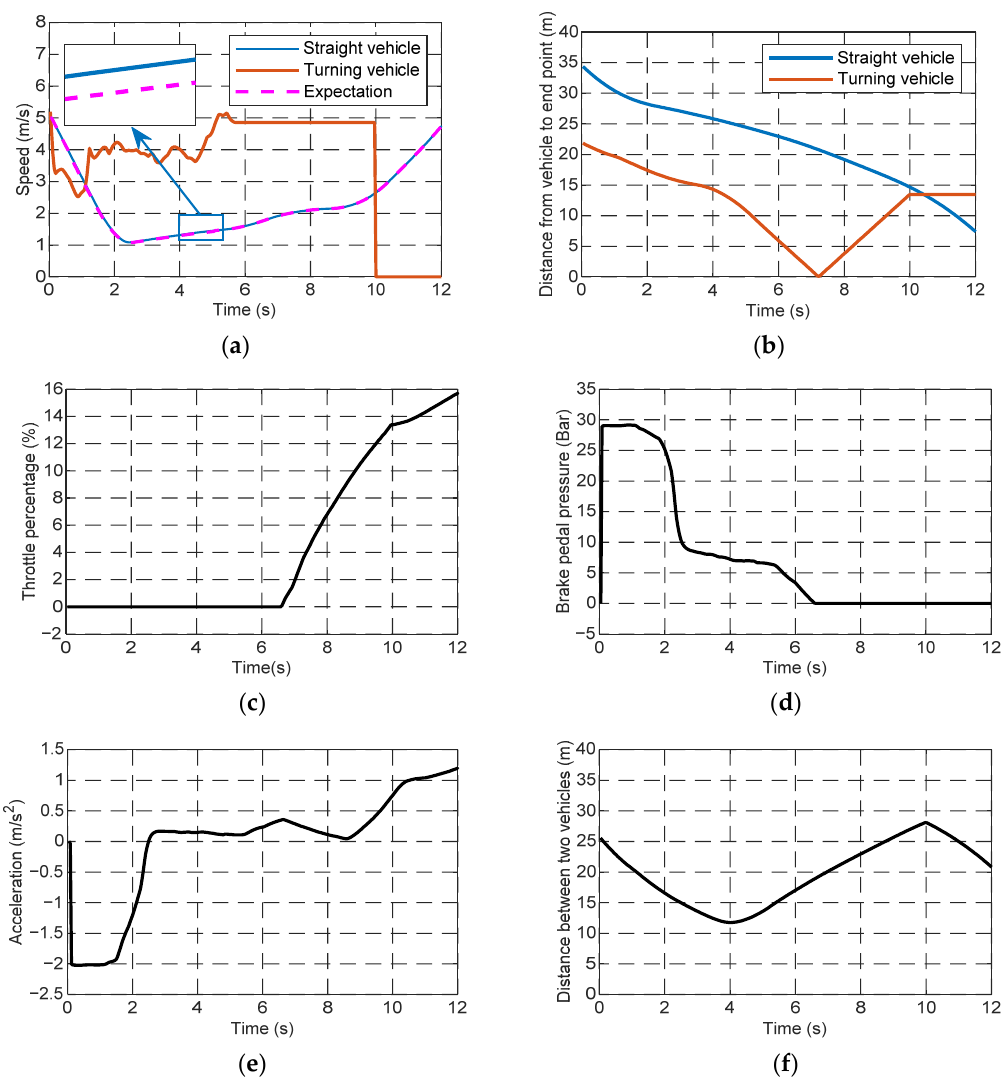
Figure 17. Simulation results of condition I: ( a ) vehicle velocity, ( b ) distance to destination, ( c ) throttle curve, ( d ) brake-press curve, ( e ) acceleration curve, and ( f ) distance between two vehicles.